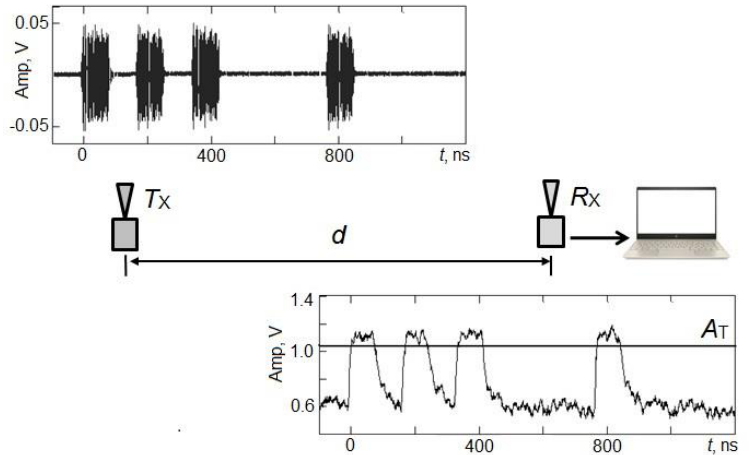
Fig. 2 . Scheme of the